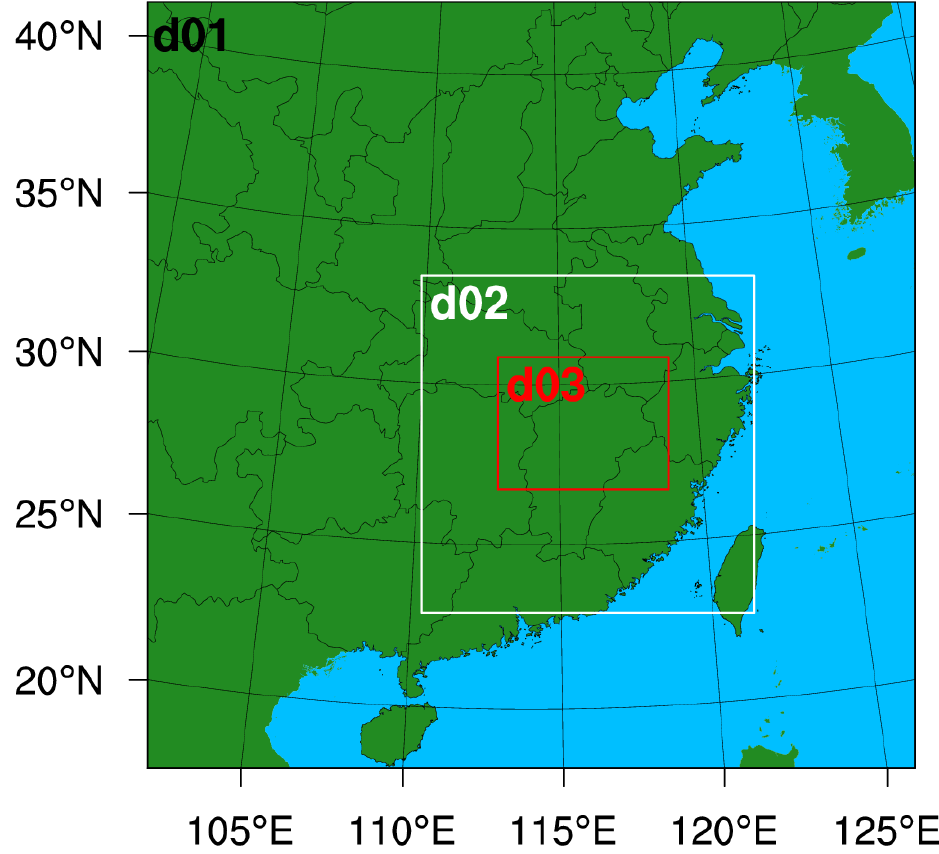
Figure 6. Model domain coverage for the 15 April 2016 case (d01, d02, and d03 represent. the outer, middle and inner domains at 9 km, 3 km, and 1 km horizontal resolutions respectively).